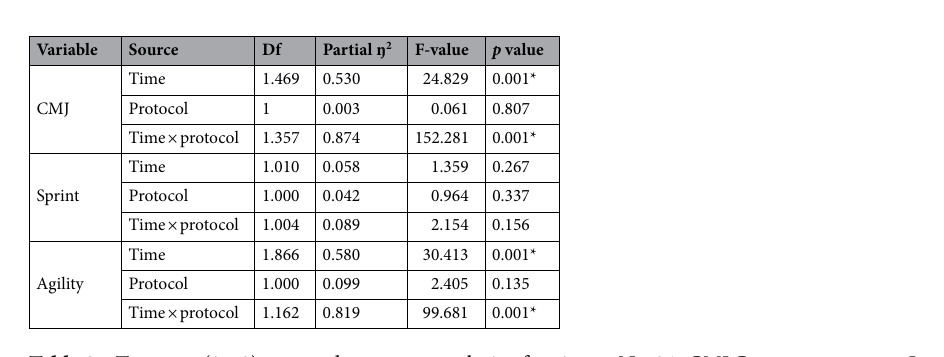
Table 2. Two-way (2 × 3) repeated measures analysis of variance. N = 24; CMJ Countermovement Jump. *Significant differences at p < 0.01.